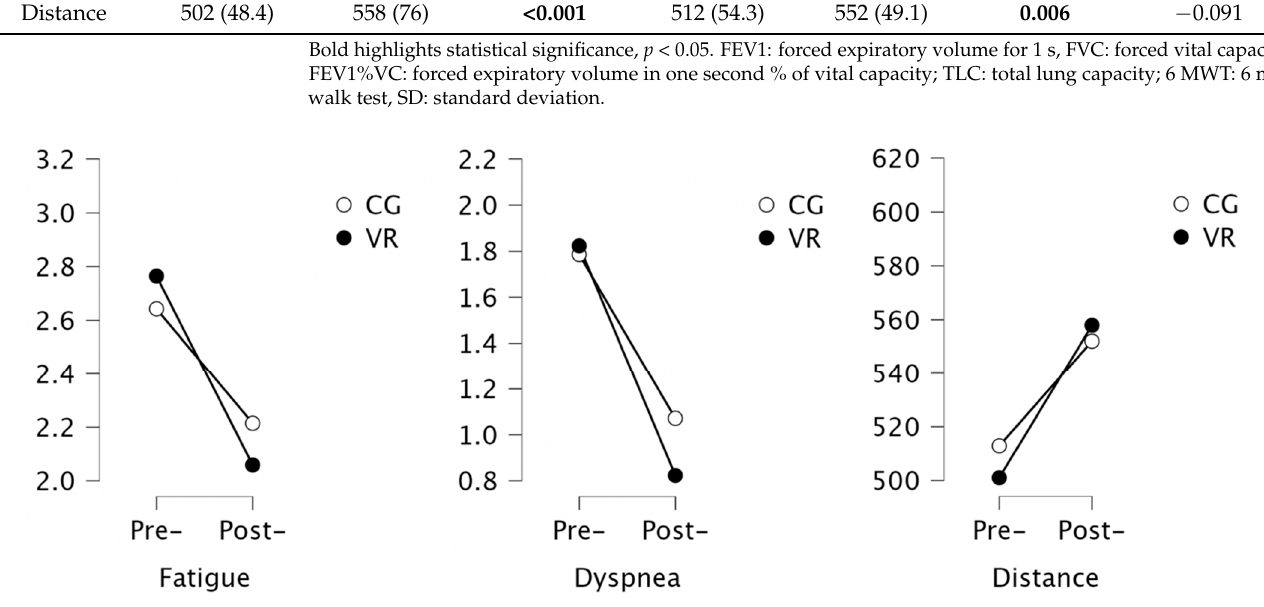
Figure 6. Results of the analysis of exercise capacity.